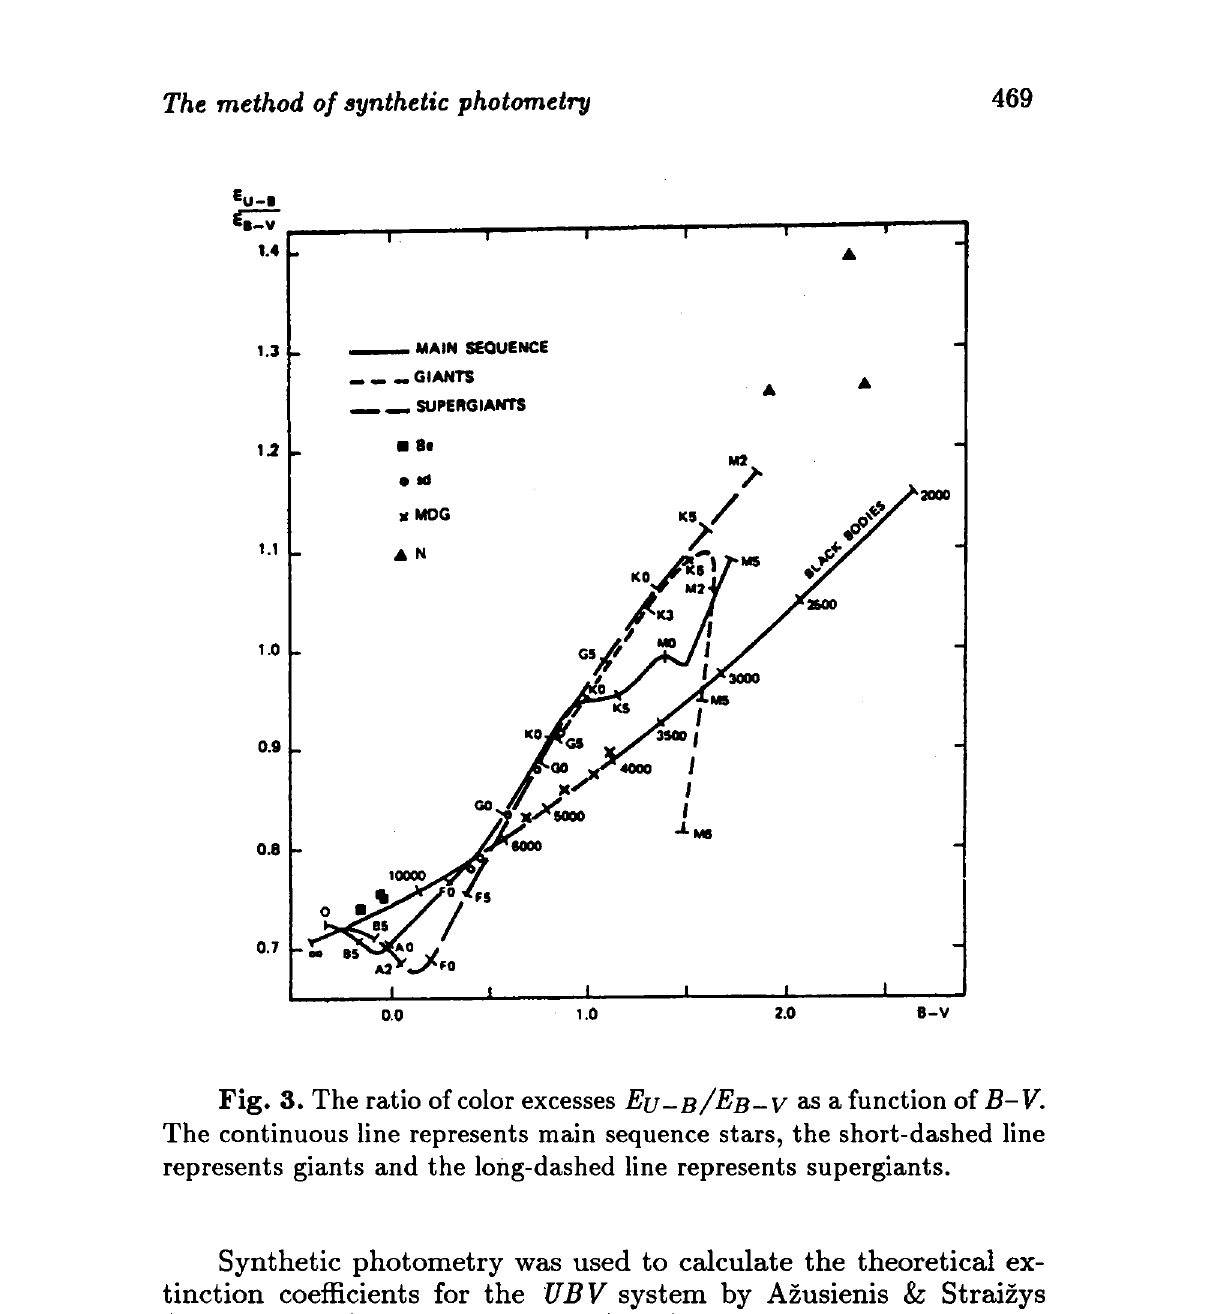
Fig. 3. The ratio of color excesses E\J~B /EB-V as a function of B-V. The continuous line represents main sequence stars, the short-dashed line represents giants and the long-dashed line represents